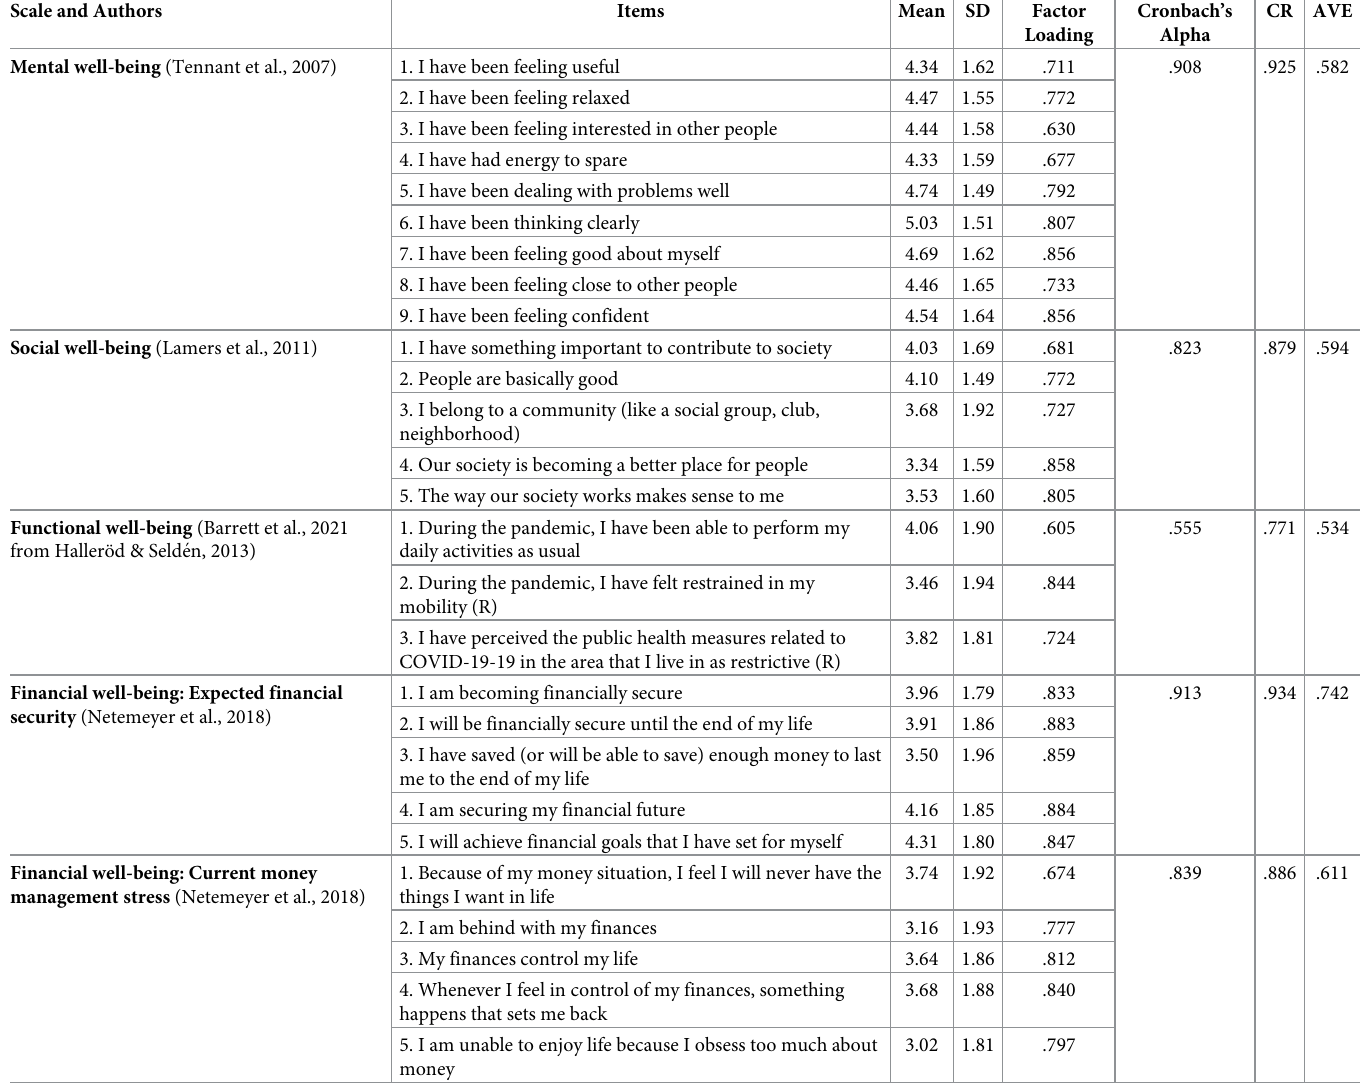
Table 3. Scale items, factor loadings, and construct validity of individual